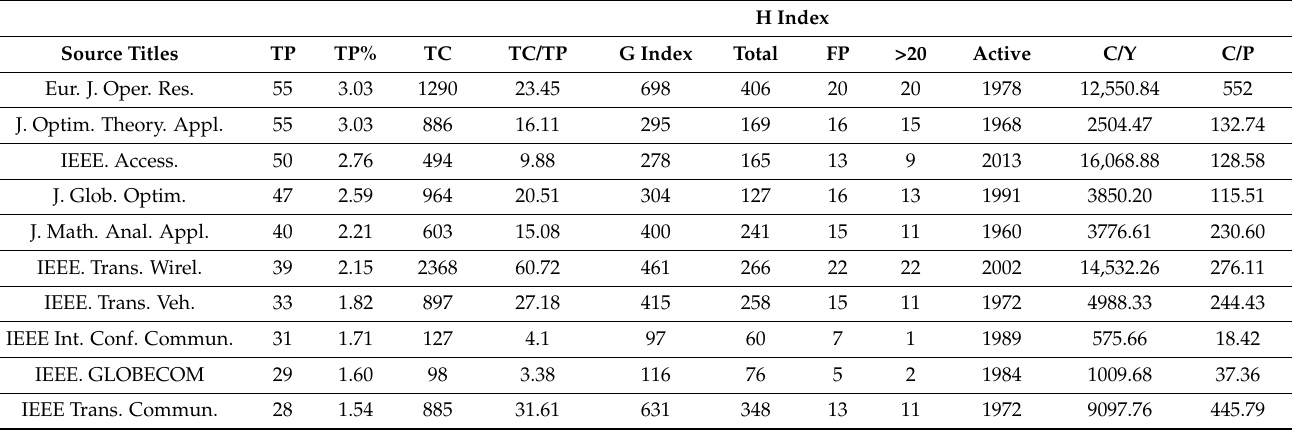
Table 2 exhibits the most prolific journals, evaluated based on six indicators. Table 2. Top 10 most productive journals in Fractional Programming.